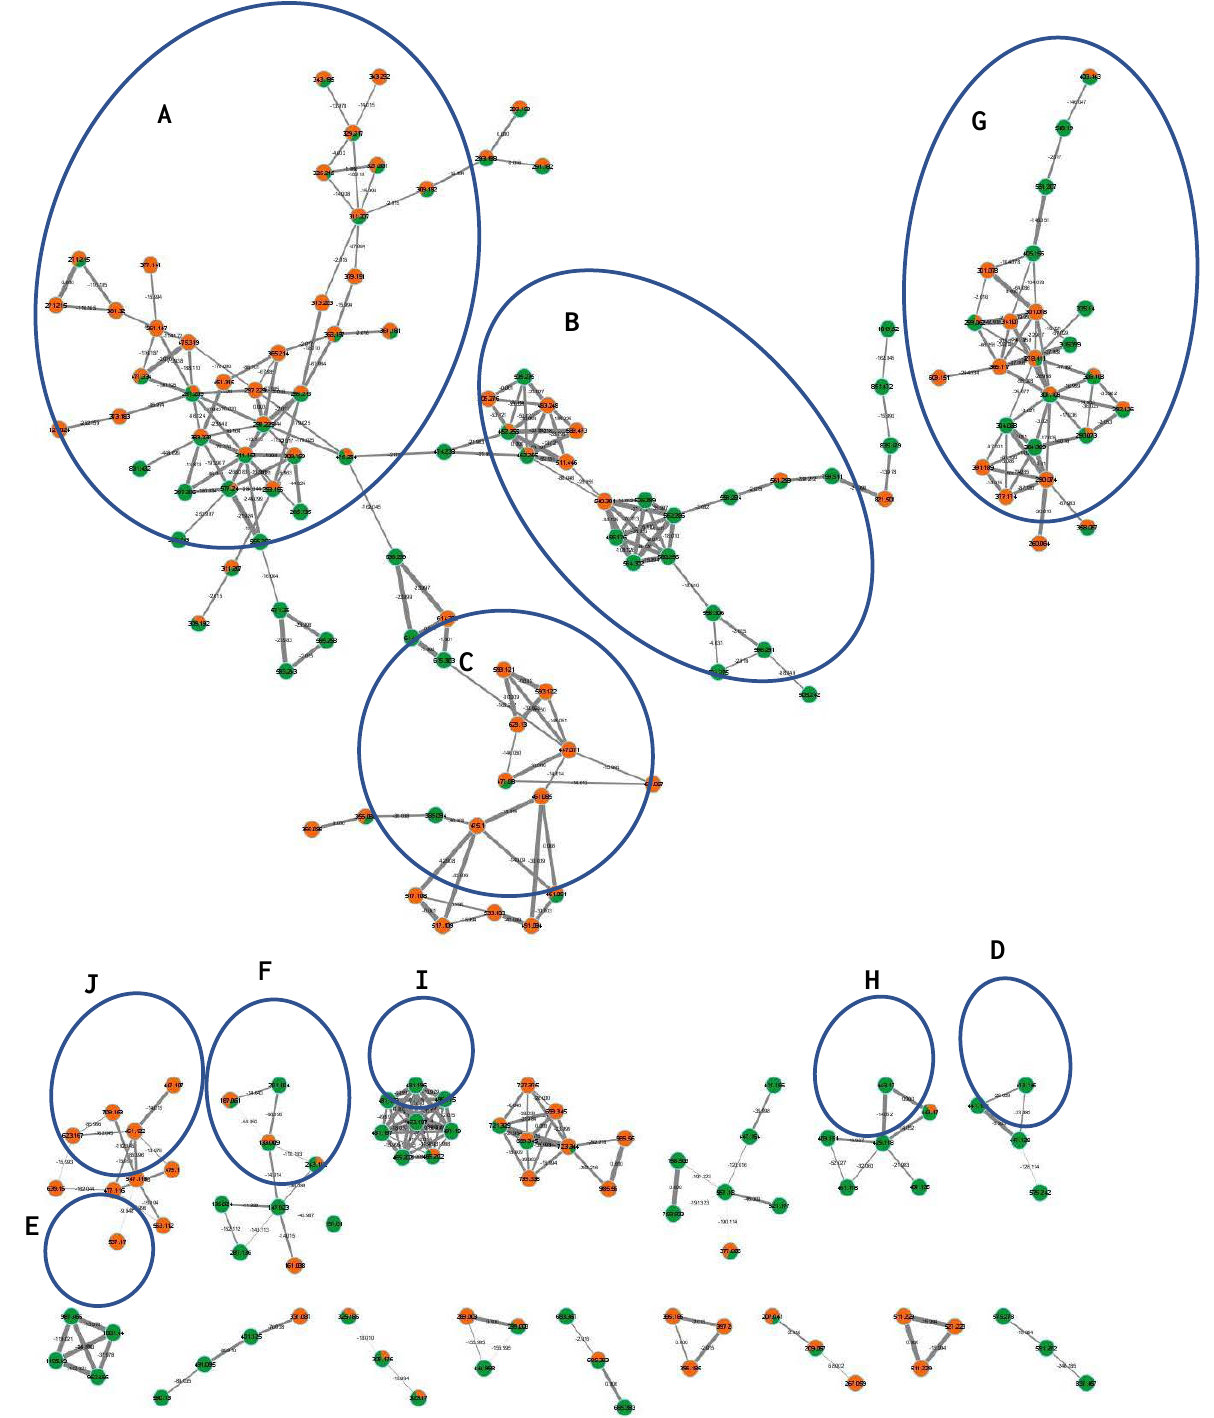
Figure 2. Full molecular networking created using MS/MS data in negative ionization mode for L. siceraria (bottle gourd) and C. sativus (cucumber) crude fruit extracts showing 351 nodes and 449 edges. All nodes are labelled with parent mass and edges are labelled with neutral loss values. The network is displayed as a pie chart with orange and green colors representing distribution of the precursor ion intensity in the bottle gourd and cucumber extracts, respectively. Clusters annotation : A : fatty acids/amides, B : lysophospholipids, C : flavonoids and ptercarpans, D : alkyl glycosides, E : saponins, F : organic acids, G : amino acids derivatives, H : sesquiterpenes, I : lysophosphatidic acid derivatives, and J : cinnamates.